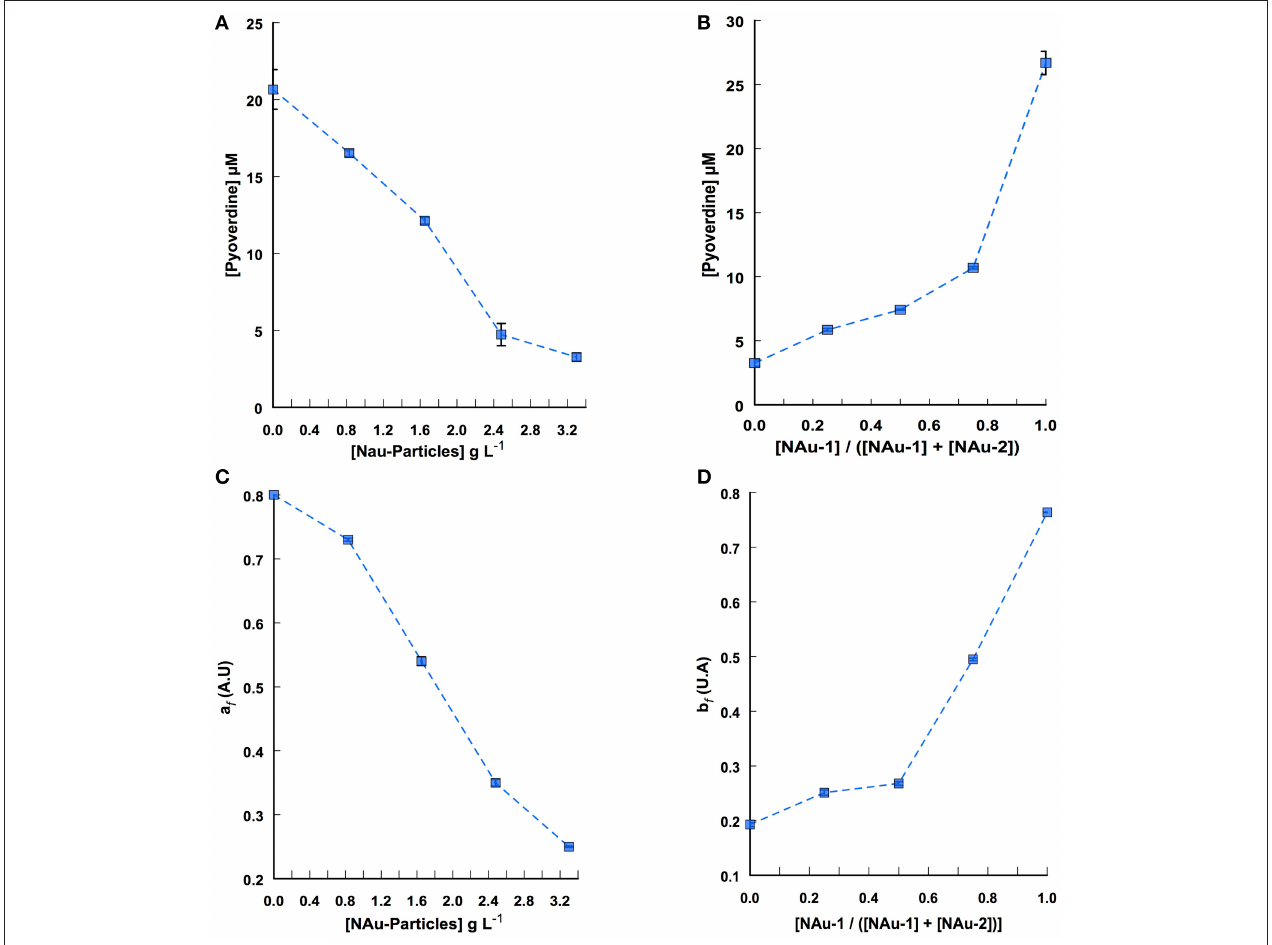
FIGURE 4 | Pyoverdine production by P. aeruginosa PAO1 incubated for 24 h in DCAA medium with increasing nontronite particle concentration and variables NAu-1 to NAu-2 ratios. (A) Pyoverdine production in assays where the NAu-1 and NAu-2 ratio is kept constant ([NAu-1]/([NAu-1] + [NAu-2]) = 0) while the particle concentration is varied. (B) Pyoverdine production in assays where the particle concentration is kept constant (3.3 g L − 1 ) with different NAu-1 to NAu-2 ratios. (C) Pattern of pyoverdine production as a function of all tested ratios over a range of particle concentrations, determined from CP decomposition of the 3-way data set. (D) Pattern of pyoverdine production as a function of all particle concentrations tested over a range of NAu-1 and NAu-2 ratios, determined from CP decomposition. a f and b f indicate the contribution of the pyoverdine signal to the global absorbance signal at any nontronite concentration and at any NAu-1 to NAu-2 ratio, respectively. Error bars represent the standard error of the mean ( n = 2), most of them are within the size of the